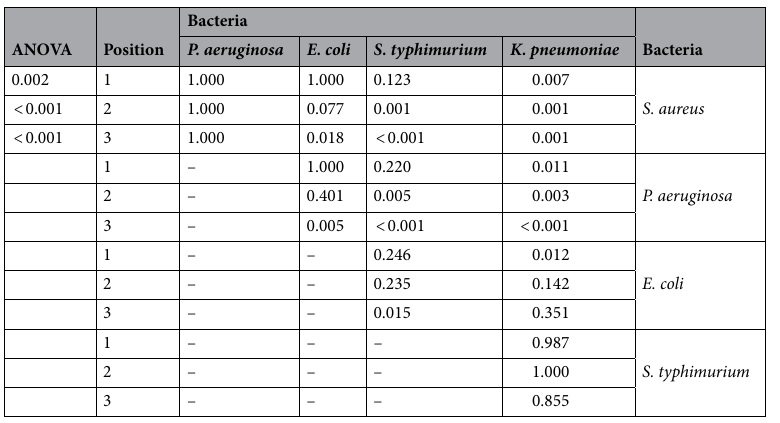
Table 2. p-values of the one-way ANOVA and of the post-hoc Bonferroni test for pairwise comparison of bacteria log 10 reduction.